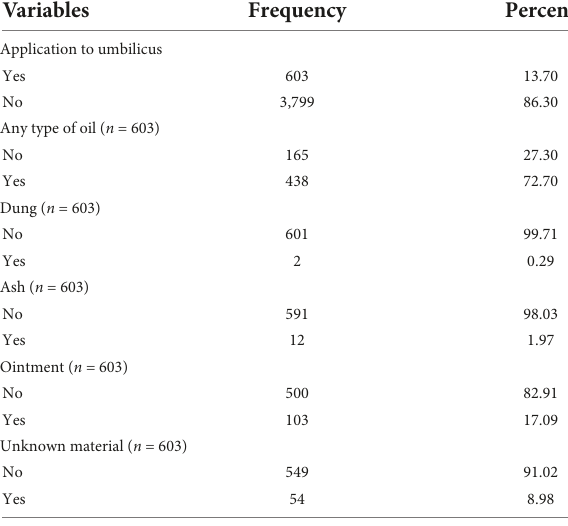
TABLE 3 Potentially harmful traditional umbilicus cord care practice among postnatal mothers in Ethiopia,